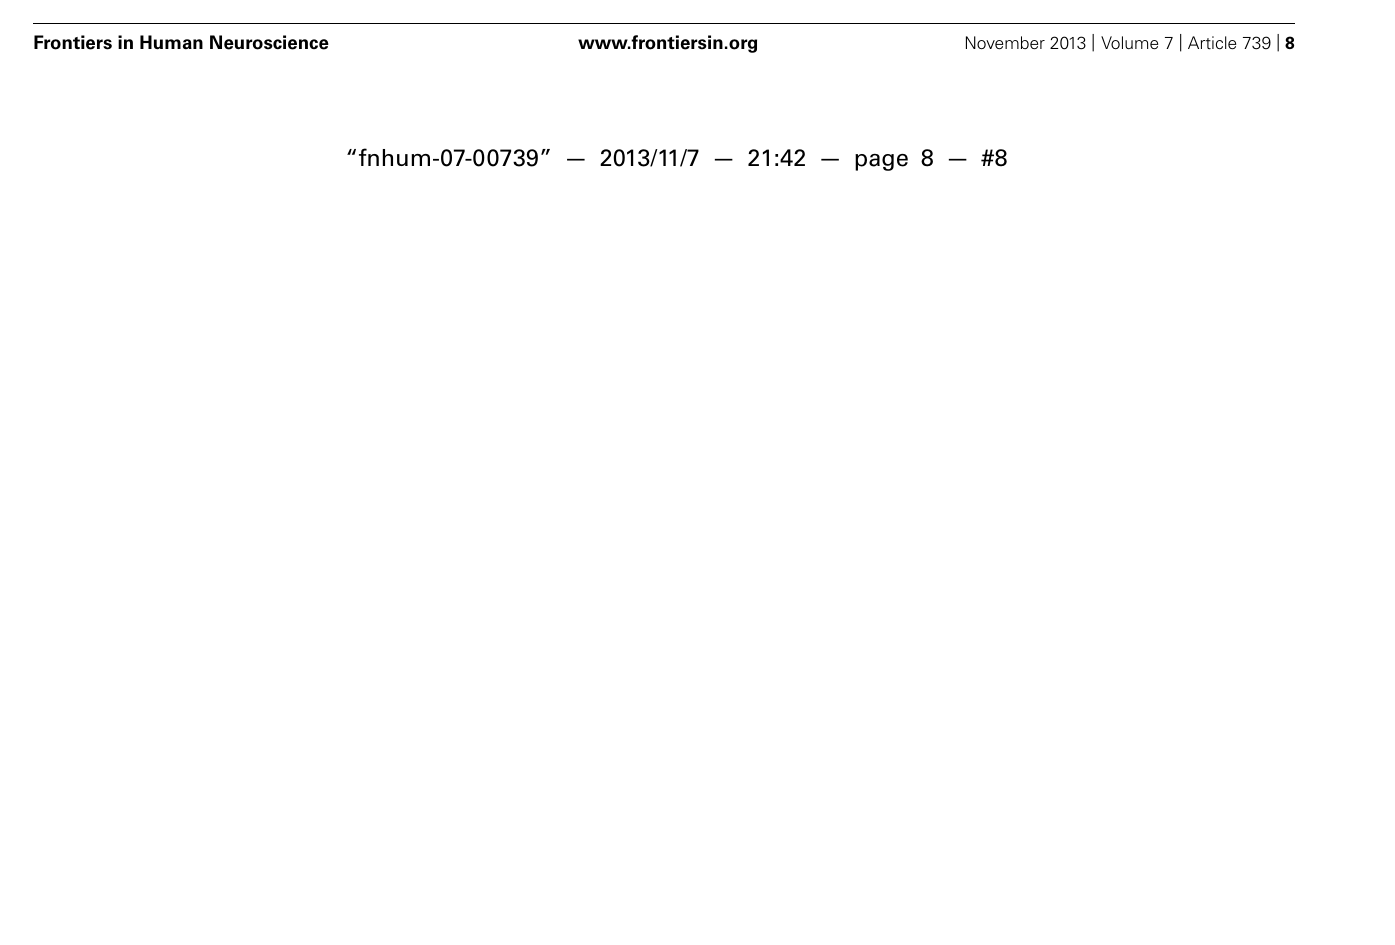
FIGURE 1 | Flow diagram of linguistic items signaling mental processes encoded from an excerpt of James Joyce’s Ulysses . The phenomenological text is divided in 30 sentence segments (Cohn, 1978, pp. 223–225) and these are plotted as arbitrary units in the temporal dimension of the abscissa.The ordinate shows four general categories of mental contents inferred (see text) from each segment (S, sensations; E, emotions;T, thoughts; I, mental